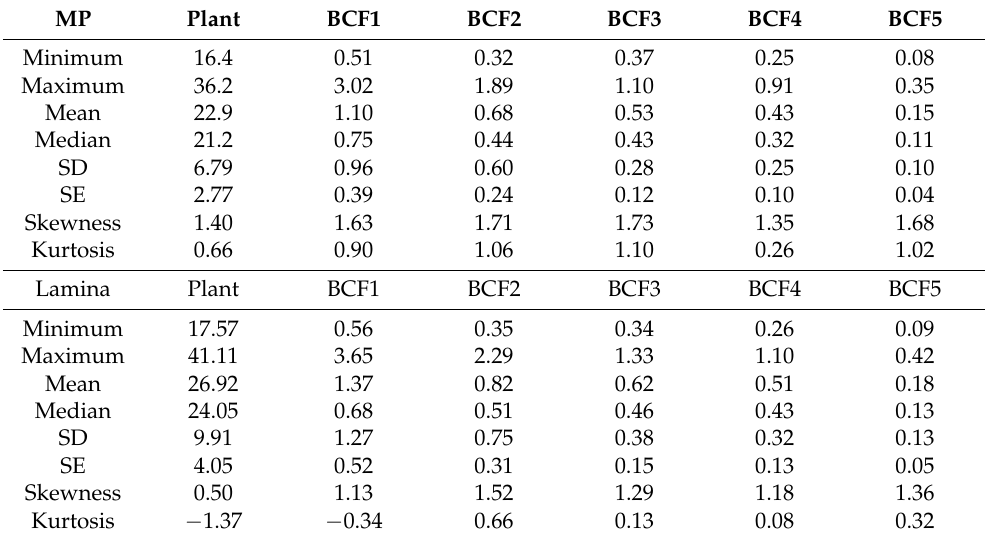
Table 8. Overall statistics of zinc (Zn) concentrations (mg/kg dry weight) in the midrib plus petiole (MP), and lamina of Avicennia officinalis , and their bioconcentration factors (BCF) values, collected from 6 sampling sites in the mangrove areas of west coast of Peninsular Malaysia.